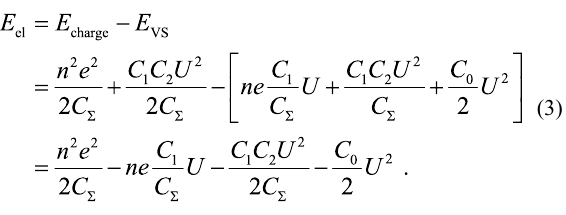
[10,11]. Furthermore magnetic forces, friction forces, capillary forces etc. can in principle occur in NC-AFM. These forces are not relevant in this paper, since, e.g., a magnetic tip is neces- sary to detect magnetic forces, or non conservative forces have to be measured to determine friction